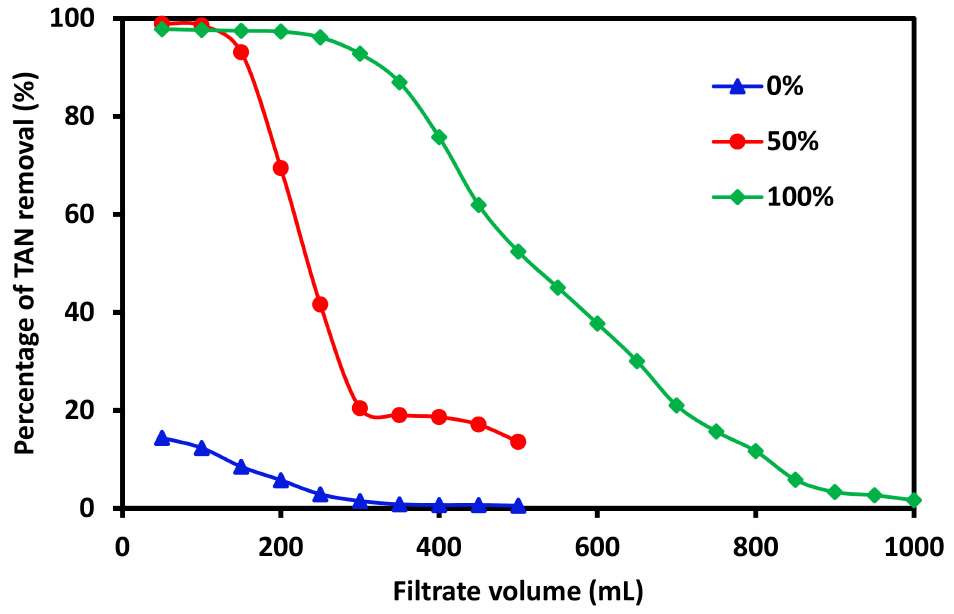
Figure 1. Percentage of TAN removed as a function of filtrate volume collected for three mixed matrix membranes incorporating 0, 50, and 100 wt% zeolite 13X with respect to PES polymer in the performance of membrane with various zeolite loadings.